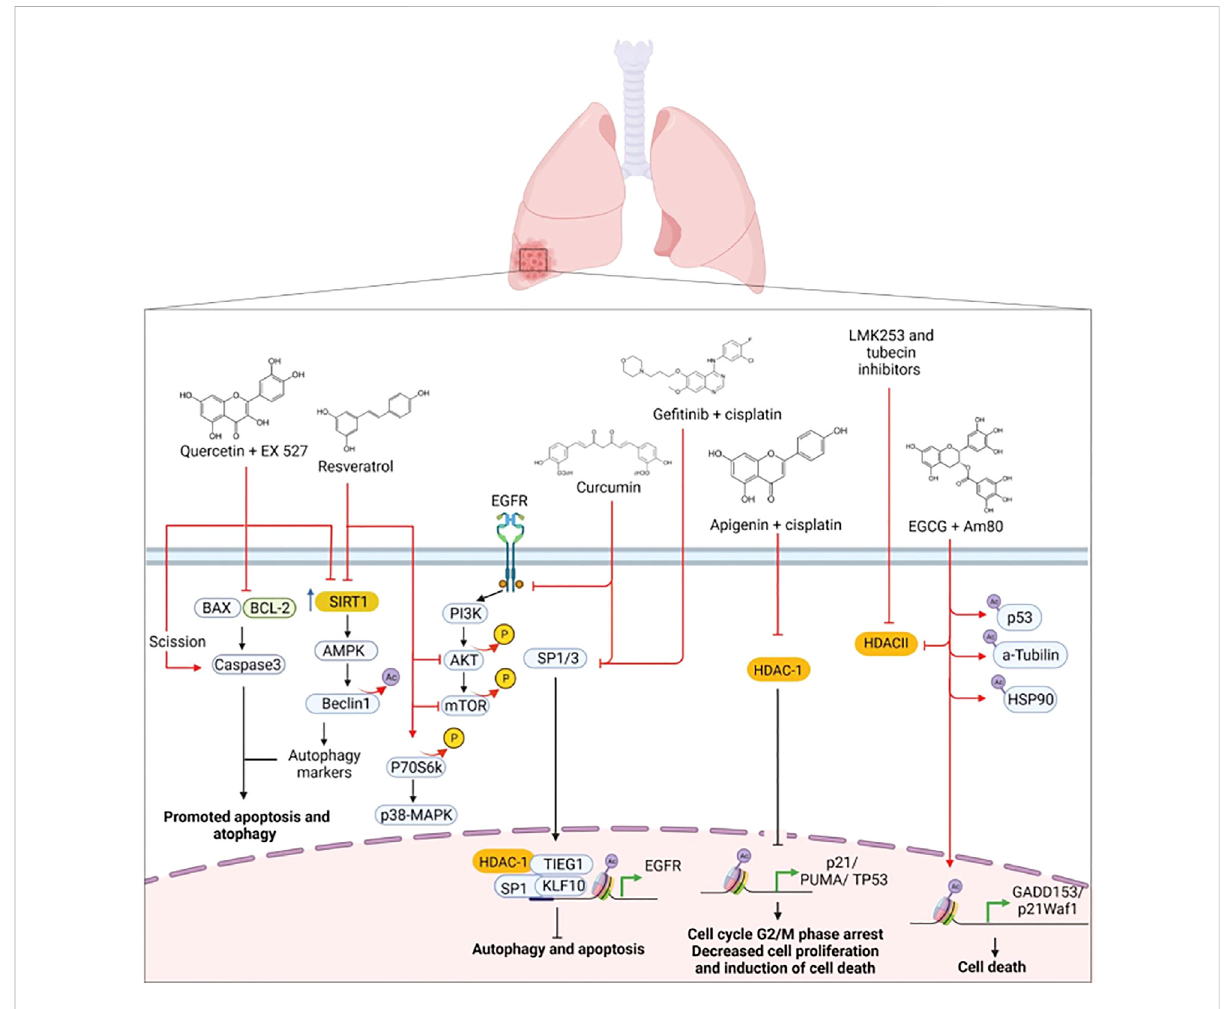
FIGURE 5 Modulation of HDACs by phytochemicals plus standard therapy in lung cancer. Phosphorylation Acetylation Up-regulation Activation Inhibition Mechanism promoted by